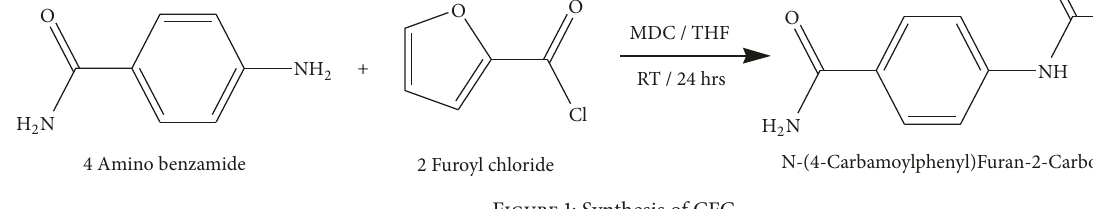
Figure 1: Synthesis of